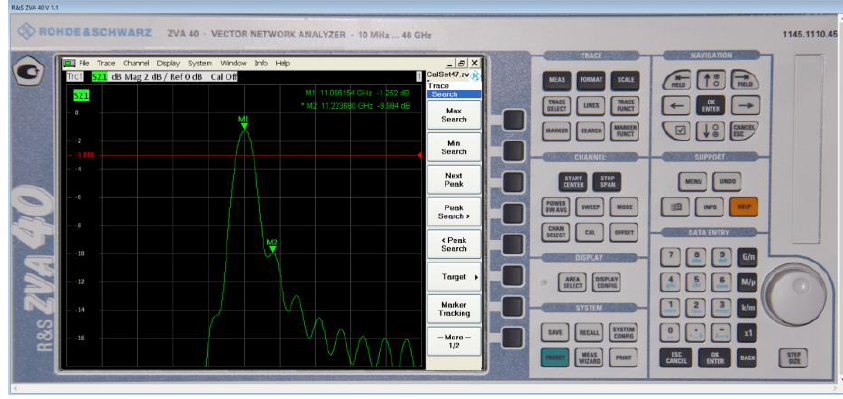
Fig. 1. Interface of vector network